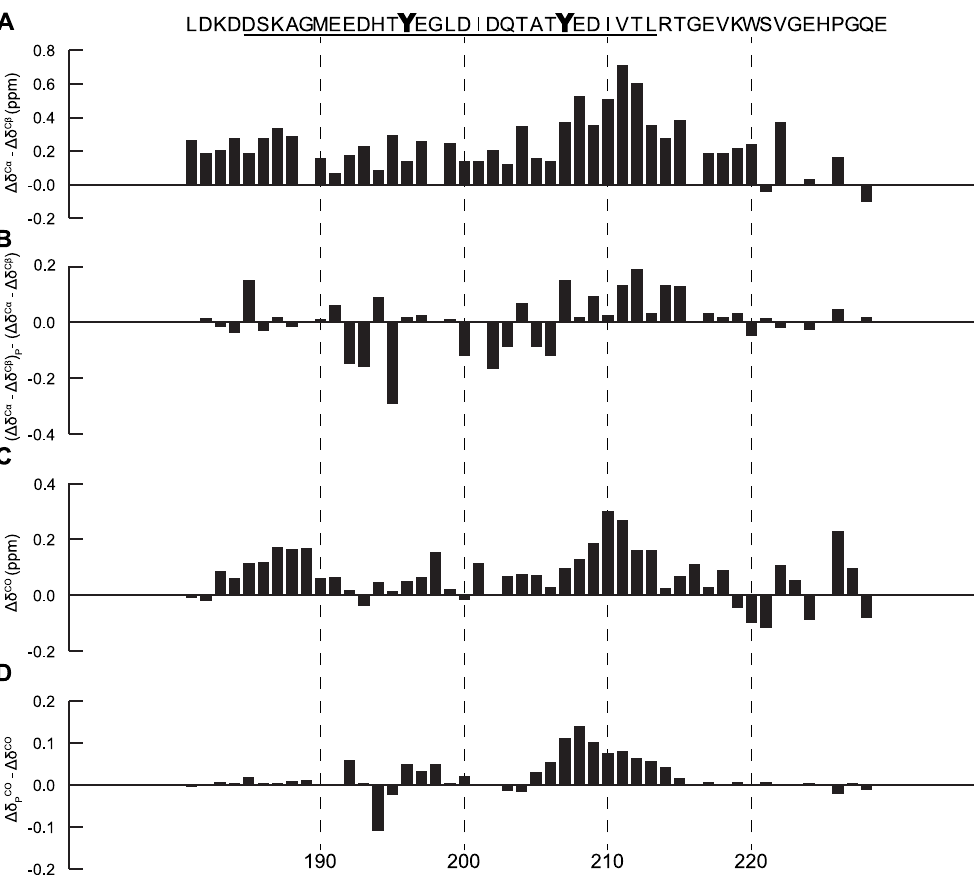
Figure 1. Secondary structure propensity of CD79b and the effects of phosphorylation. The ITAM region in the sequence is underlined and all shifts are plotted against their corresponding residue number ( A ) positive values of secondary chemical shifts ( Dd C a – Dd C b ) indicate an overall tendency for a -helical structure with an increased propensity in the region Thr206 to Gly216. ( B ) change of secondary chemical shifts upon phosphorylation ( Dd C a – Dd C b ) P –( Dd C a – Dd C b ). Positive values for residues Tyr207 to Gly216 indicates an increased helical content in this region following phosphorylation. ( C ) Dd CO secondary chemical shifts. The Dd CO shift pattern agrees well with the pattern of ( Dd C a – Dd C b ) indicating an overall tendency for a -helical structure ( D ) change of secondary chemical shifts ( Dd PCO – Dd CO ). Phosphorylation increases the tendency for a -helical structure in the C-terminal part of the ITAM region.